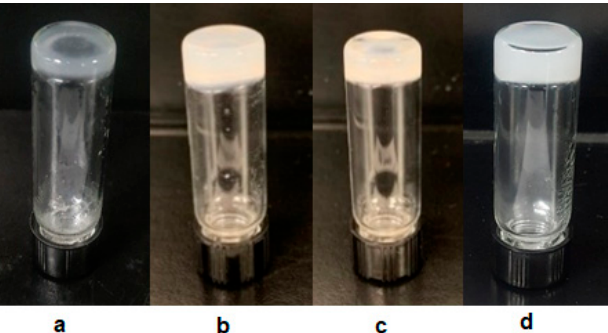
Figure 2. The gels formed by several compounds. ( a ) A translucent gel formed by compound 4d in DMSO: H 2 O (1:1) at 10.0 mg/mL; ( b ) an opaque gel formed by compound 7c in DMSO:H 2 O (1:1) at 3.3 mg/mL; ( c ) an opaque gel formed by compound 7c in glycerol at 5.0 mg/mL; ( d ) an opaque gel formed by compound 7d in EtOH:H 2 O (1:1) at 3.3 mg/mL.